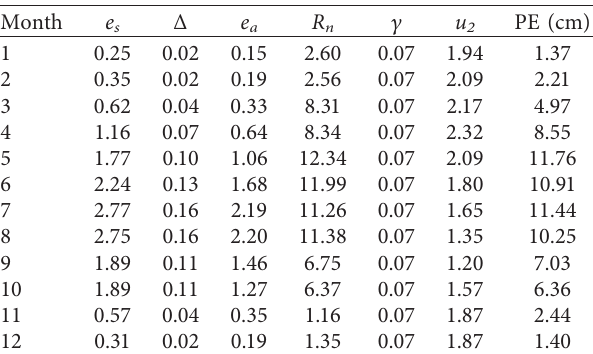
Table 3: PE calculation process.